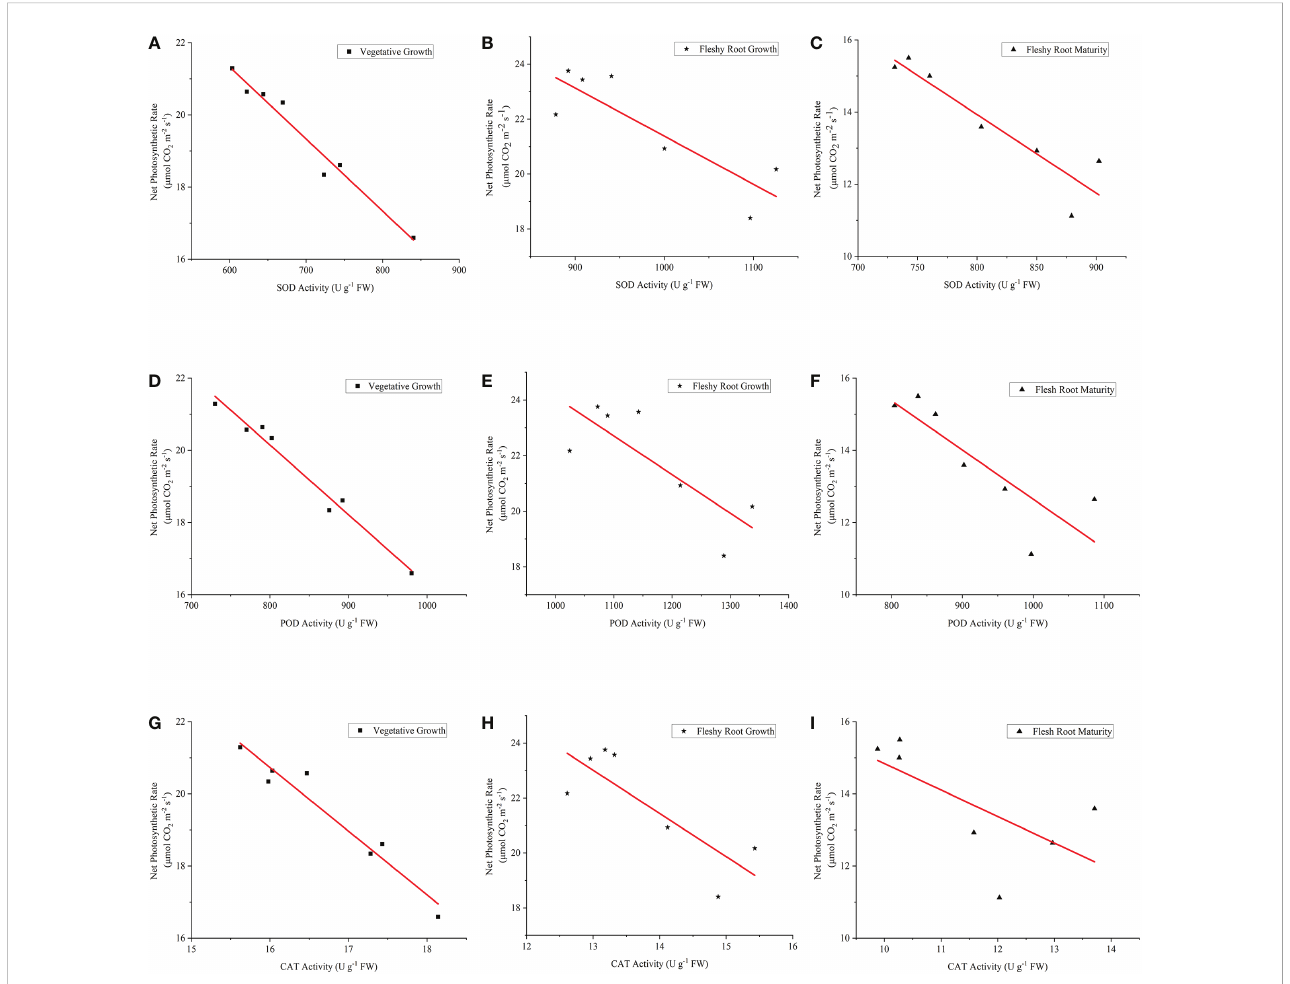
FIGURE 9 The relationship between Pn and the antioxidant enzyme activities of woad. (A – C) describe the relationship between Pn and SOD in vegetative growth, fl eshy root growth and fl eshy root maturity, respectively. (D – F) describe the relationship between Pn and SOD in vegetative growth, fl eshy root growth and fl eshy root maturity, respectively. (G – I) describe the relationship between Pn and SOD in vegetative growth, fl eshy root growth and fl eshy root maturity, respectively. Pn: the net photosynthetic rate; SOD, superoxide dismutase; POD, peroxidase; CAT,